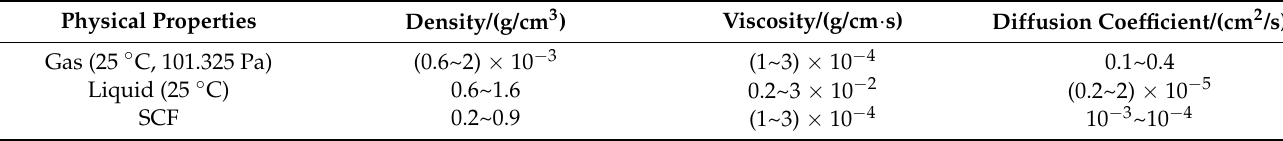
Table 4. Physical properties of gas, liquid and supercritical fluid (SCF).